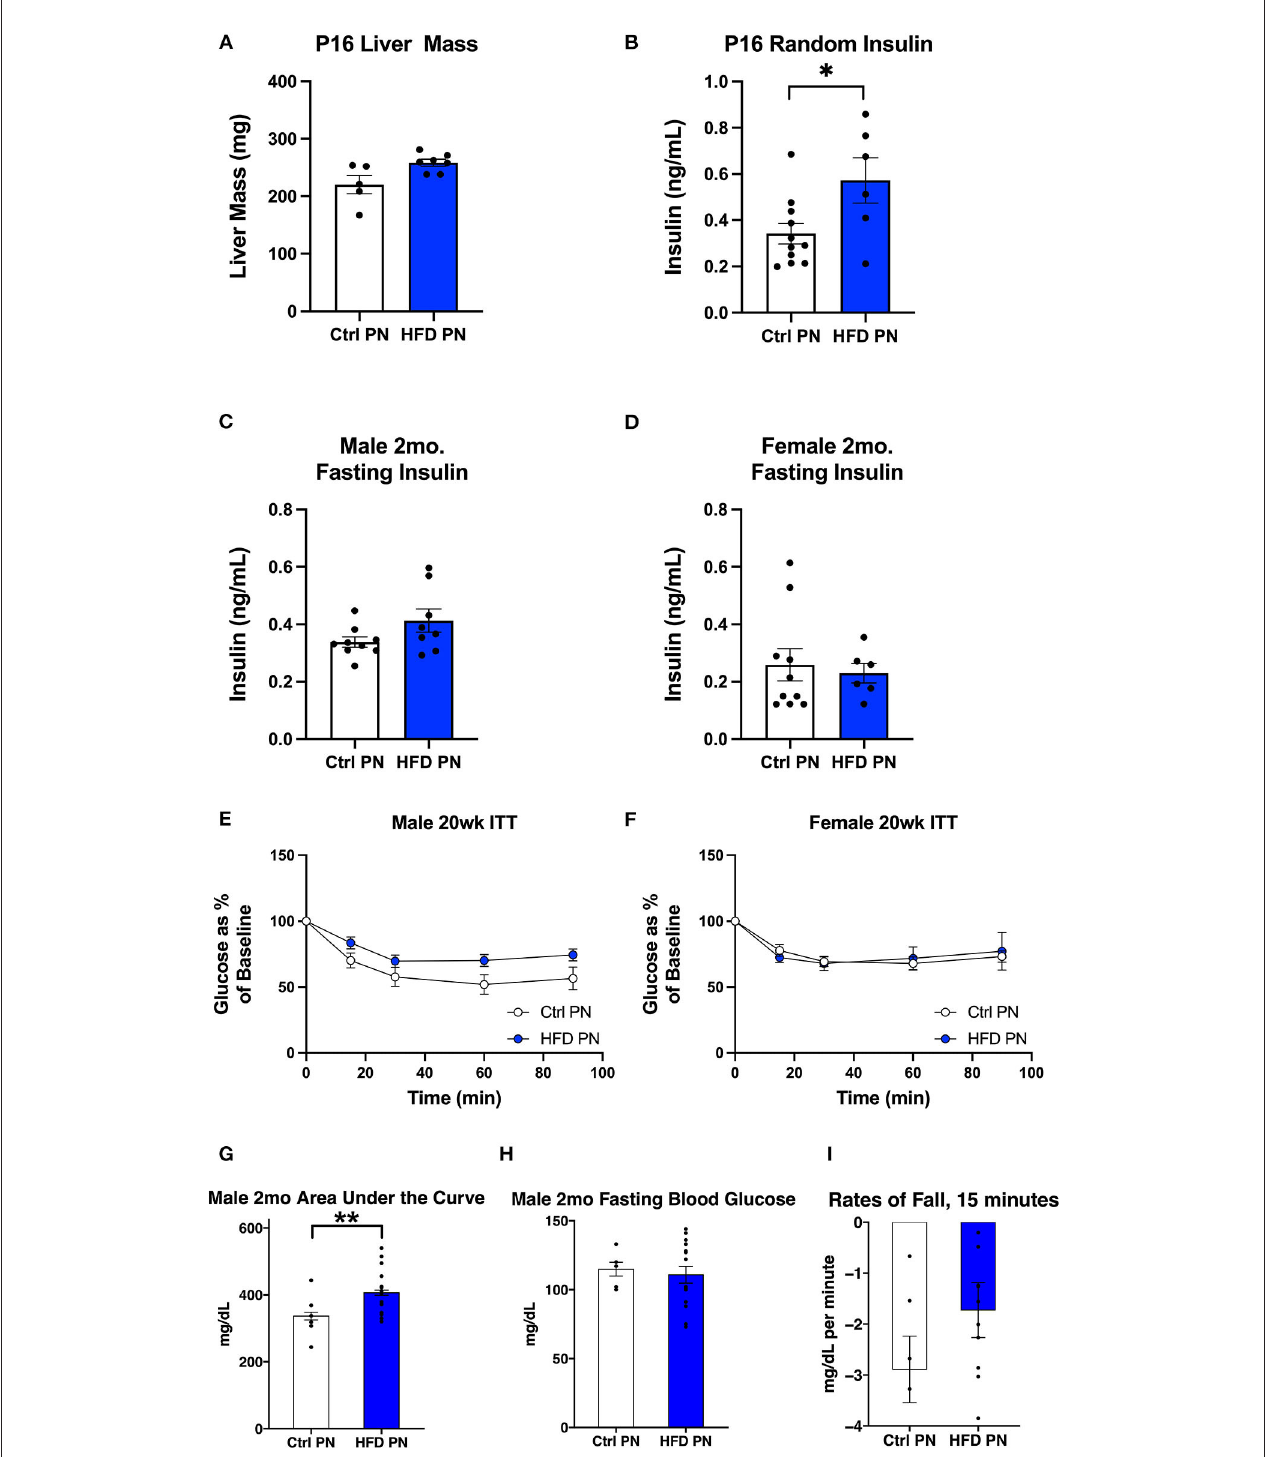
FIGURE 2 | Offspring metabolic characteristics after lactational exposures. All data are presented as a litter average with the n reflecting the number of litters studied. All white values are for Ctrl PN and blue are for HFD PN offspring. (A) Post-natal day 16 (P16) Liver Mass (B) P16 Fed Insulin (C) . Fasting insulin at 2 months in male offspring (D) . Fasting insulin at 2 months in female offspring (E) . Insulin tolerance test at 5 months in male offspring ( n = 6–7 litters) (F) . Insulin tolerance test at 5 months in female offspring ( n = 4–7 litters) (G–I) constitute further analysis of the 5-month male ITT (G) . The area under the curve from 100% for the ITT glucose values (H) . Fasting blood glucose at the start of the ITT (I) . The rate of fall in blood glucose from the baseline to 15min during the test. Ctrl, control; HFD, high-fat diet; PN, post-natal. * p < 0.05.